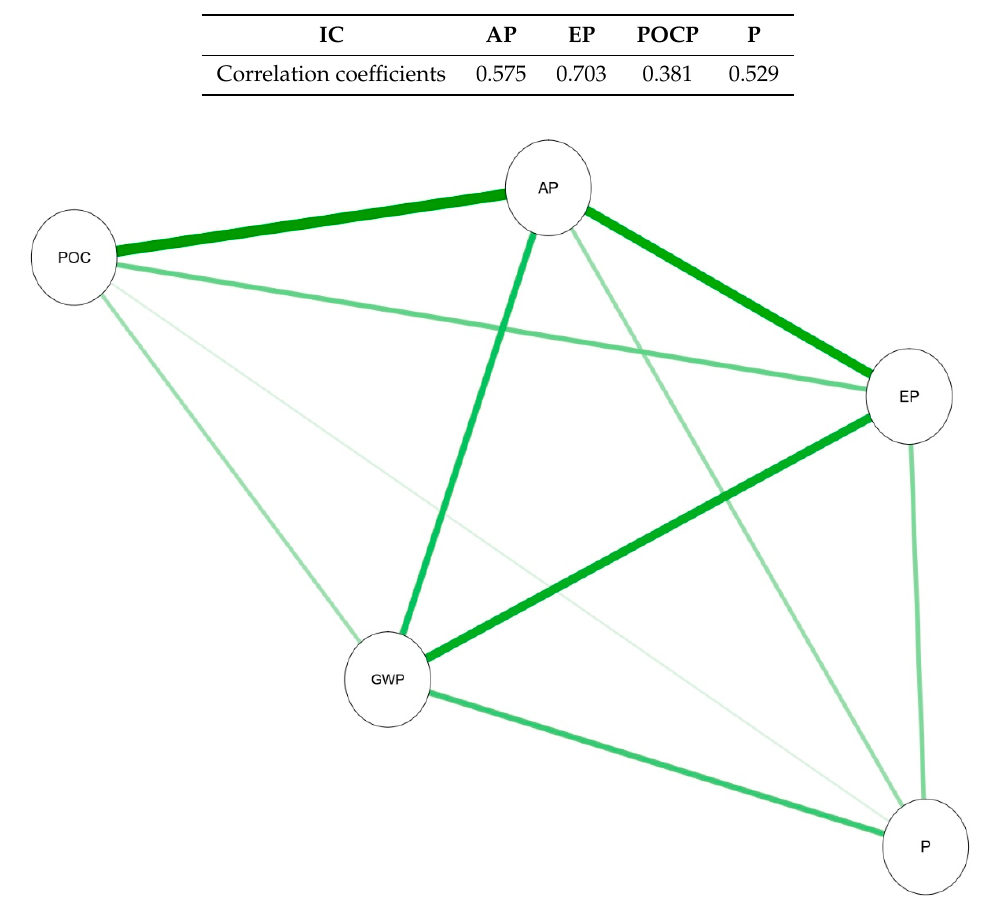
Figure 2. Correlation among Emission ICs.